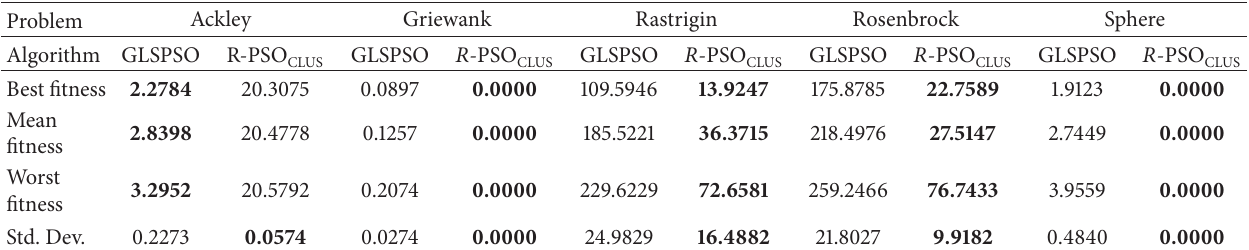
for problems with dimension of 30. CLUS